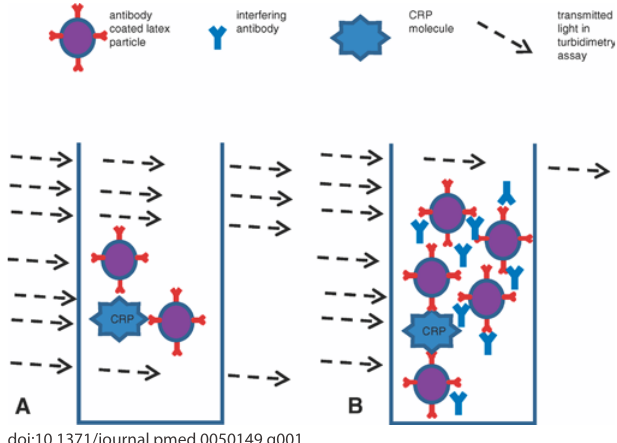
Figure 1. Schematic Illustrating One Possible Mechanism of How Antibody Interferes with PETIAs (A) In PETIAs, latex particles coated with antibody against CRP bind specifically to the target. This increases the turbidity of the sample, resulting in a decreased transmission of light, which reads as an increased concentration of CRP. (B) In interference by, e.g., monoclonal antibody, the antibody binds the anti-CRP-coated beads, increasing turbidity and leading to falsely elevated readings of CRP